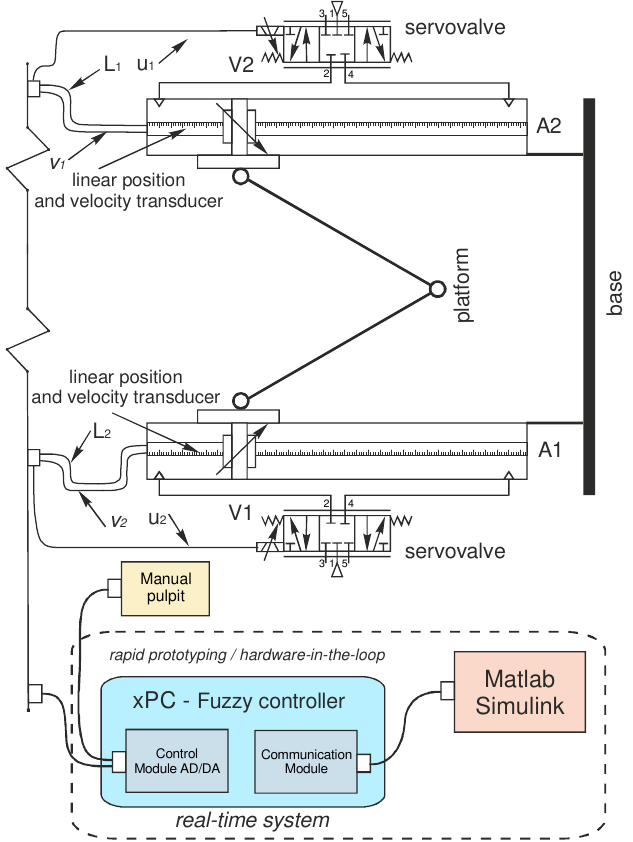
Figure 3. The diagram control system of a parallel manipulator: A1, A2—rodless actuators, V1, V2—5/3 proportional flow valves, u1, u2—voltage signals controlling the valves, L1, L2—voltage signals of the actuators’ pistons, V1, V2—voltage signals of the velocity of the actuators’ pistons, 1 — pressure supply, 2, 4 — working ports, 3, 5 — exhausts.